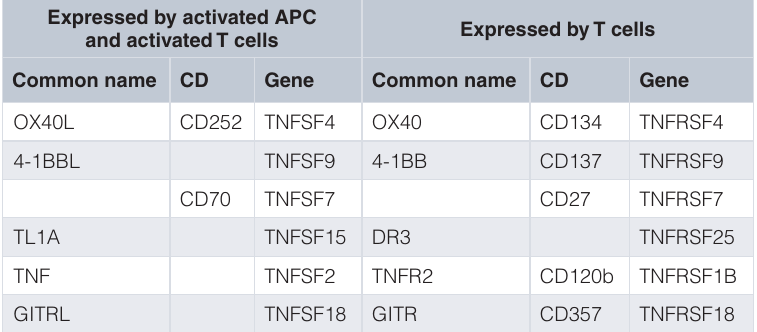
Table 1. The gene names refer to the systematic names (TNF superfamily and TNF receptor